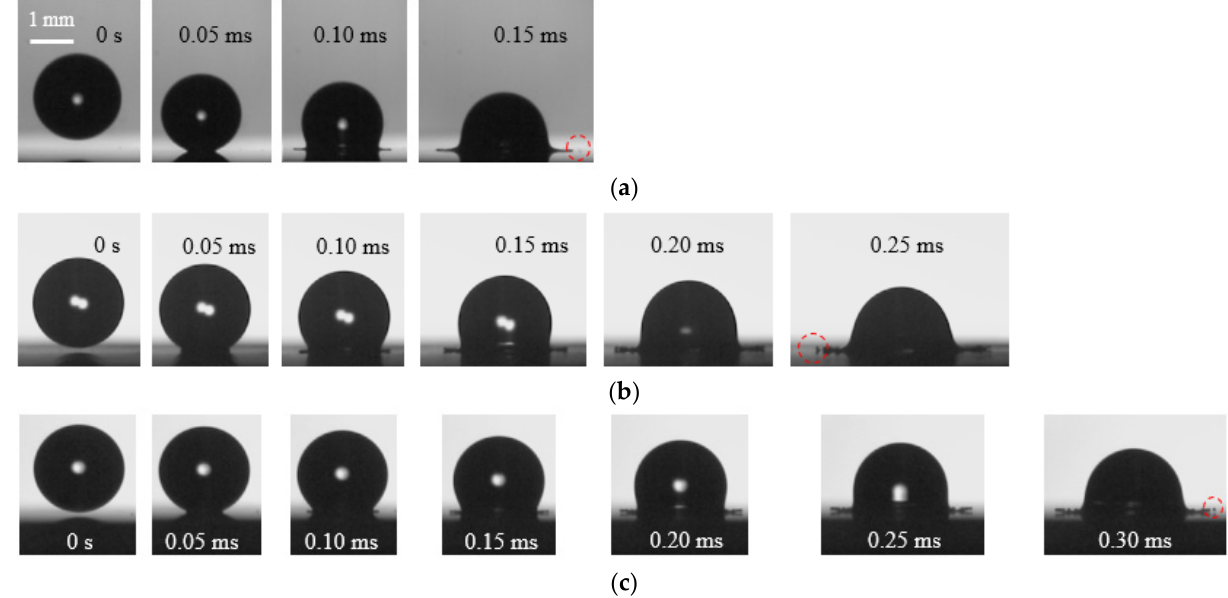
Figure 2. Splashing images of droplets on solid substrates: ( a ) 0 wt% droplet on bare substrate; ( b ) 0 wt% on #400 substrate; and ( c ) 99.4 wt% substrate. Droplet volumes are 4.5 μ L for water and 4.8 μ L for 99.4 wt%. The red dashed circle represents the firstly ejected secondary droplet from the rim of the liquid film.